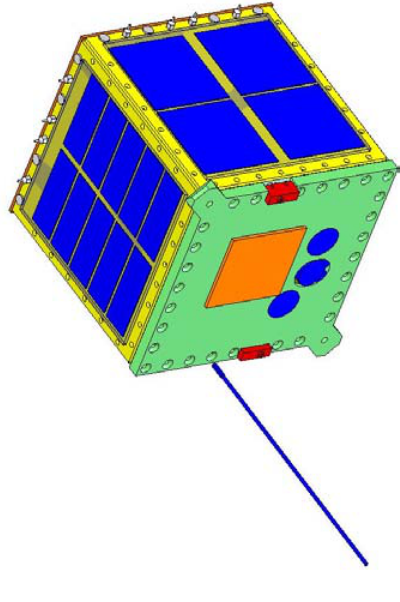
Fig3. Nanosatellite PicPot